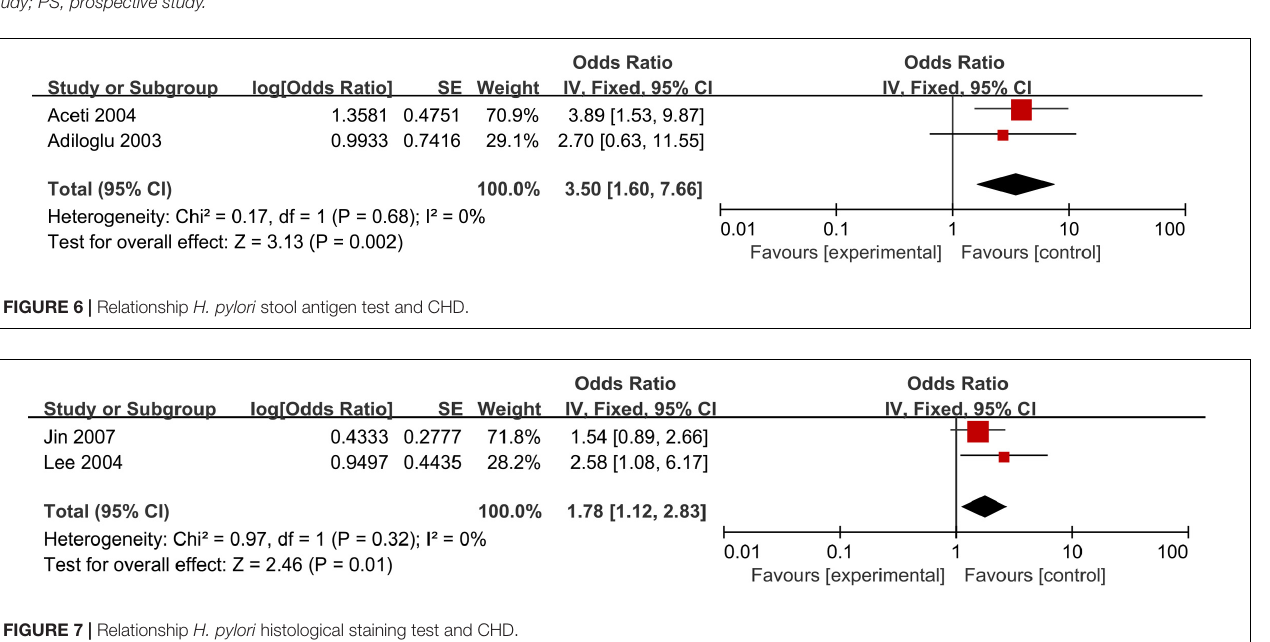
FIGURE 7 | Relationship H. pylori histological staining test and